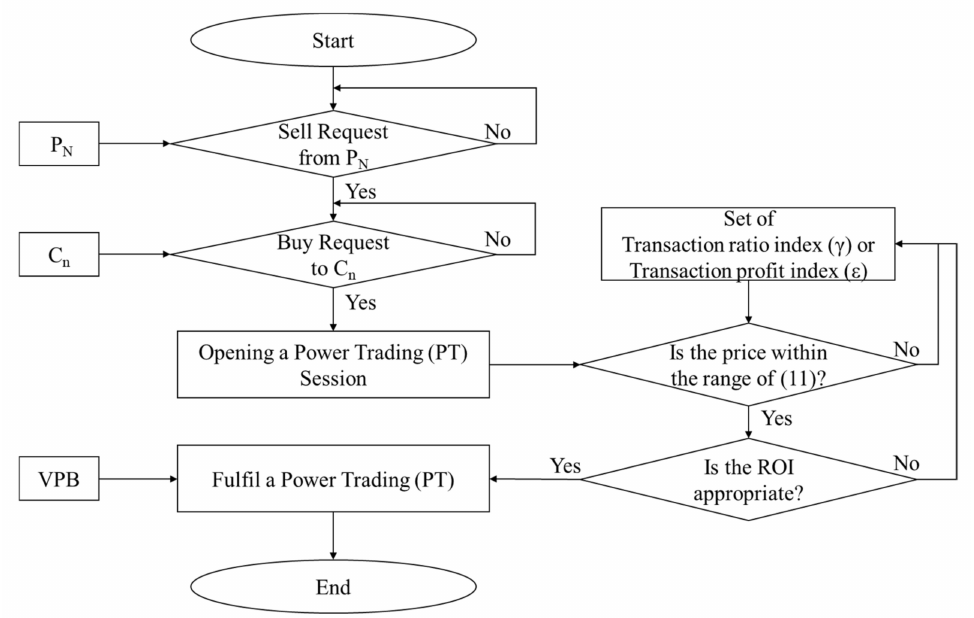
Figure 15. Algorithm of the proposed